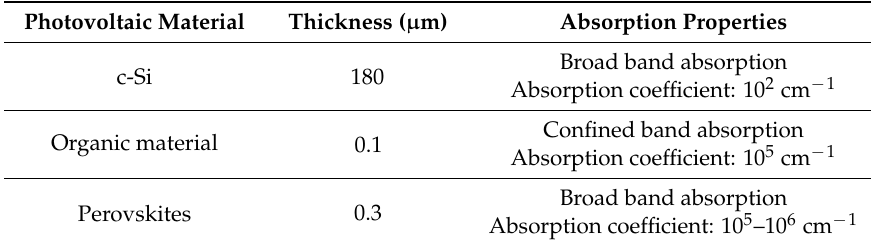
Table 1. Comparison of thickness and absorption properties between various semiconductor materials used in solar